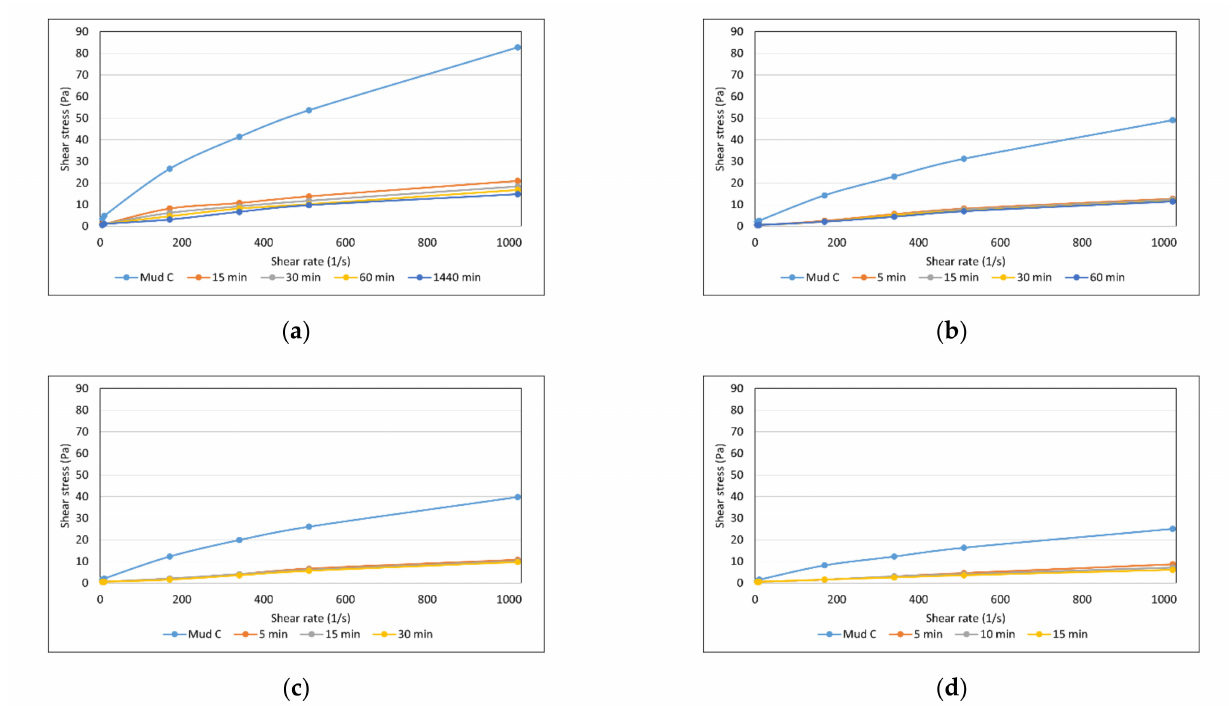
Figure 11. Flow curves of drilling mud C with 1.0% urea peroxide: ( a ) at 20 ◦ C, ( b ) at 40 ◦ C, ( c ) at 60 ◦ C, ( d ) at 80 ◦